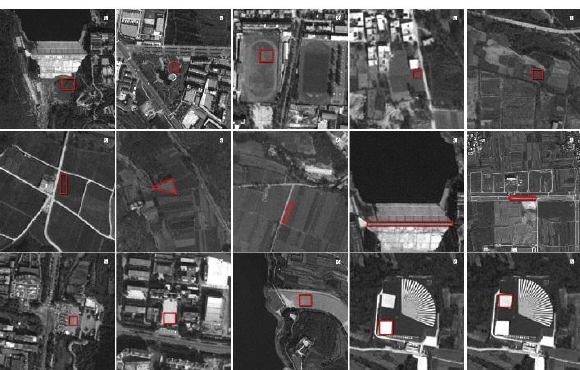
Figure.7 Examples of 14 kinds of objects (the last two